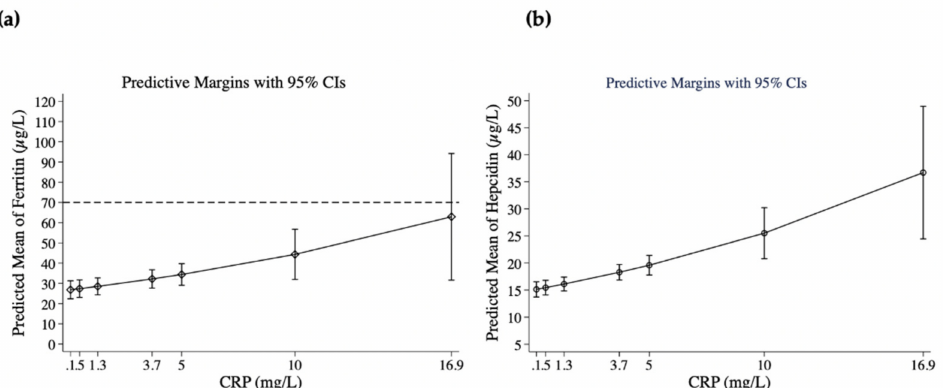
Figure 3. Predictive probabilities of ( a ) ferritin ( µ g/L) and ( b ) hepcidin ( µ g/L) at quantile concen- trations of CRP (mg/L): 0.1 (minimum), 0.5 (25th quantile), 1.3 (median), 3.7 (75th quantile), and 16.9 (maximum). Additional values at CRP (5 and 10 mg/L) are shown. Predictive margins are controlled for other variables entering the MFP regression model for ferritin excluding hepcidin (Table 4B) and for hepcidin excluding ferritin (Table 4D). The dashed line denotes the WHO cut-off for low ferritin in populations with